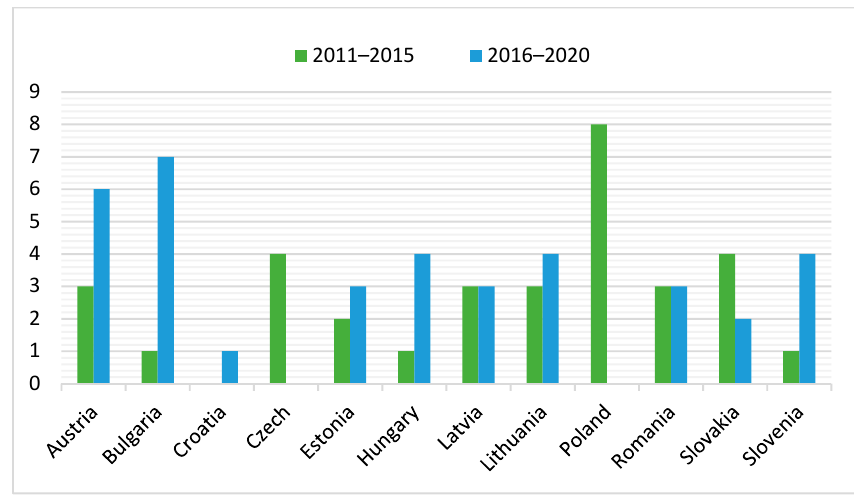
Figure 6. Top bilateral visits 3SI countries–UAE. Data based on the MOFAiC [26].